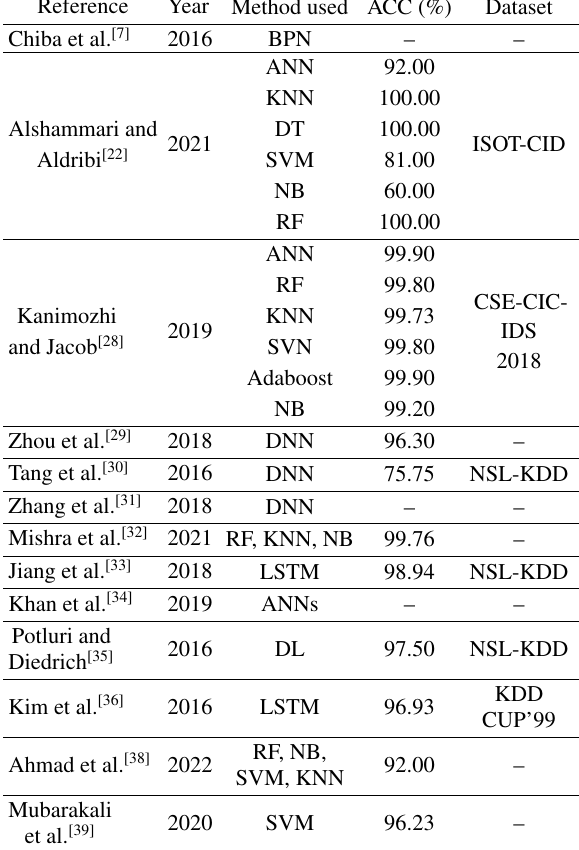
Table 1 Comparison of various current IDS models.